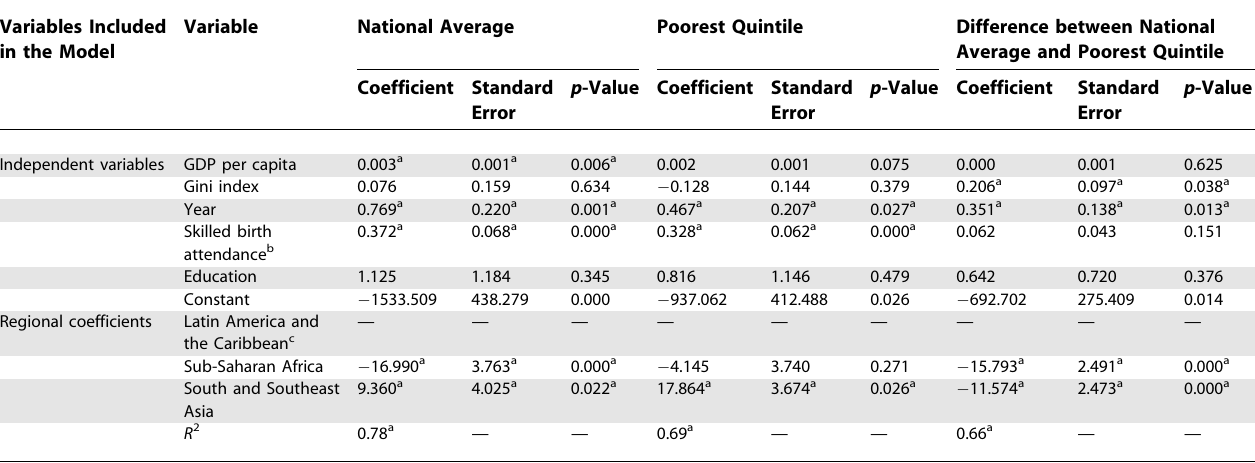
Table 2. Results from Multivariate Regression Models Variables Included Variable National Average Poorest Quintile Difference between National in the Model Average and Poorest Quintile Coefficient Standard p -Value Coefficient Standard p -Value Coefficient Standard p -Value Error Error Error Independent variables GDP per